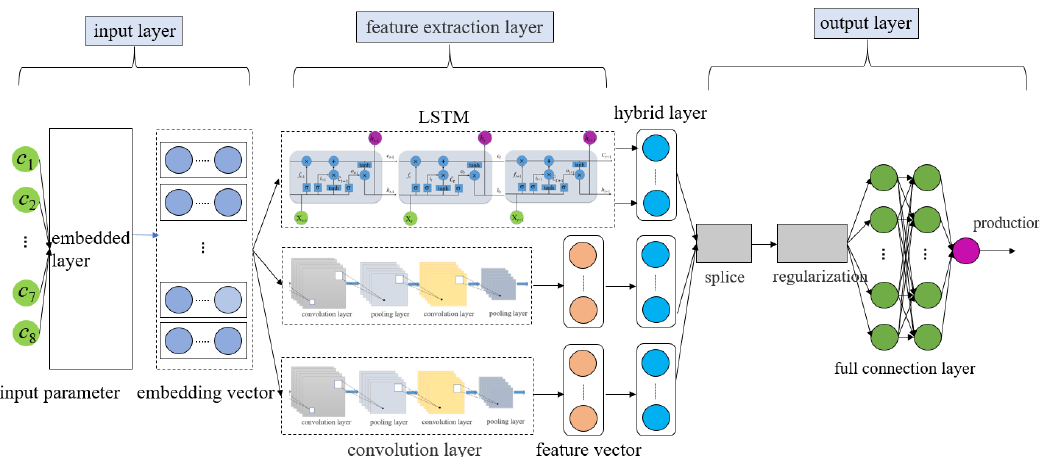
Figure 6. Structure of the CNN-LSTM neural network diagram.